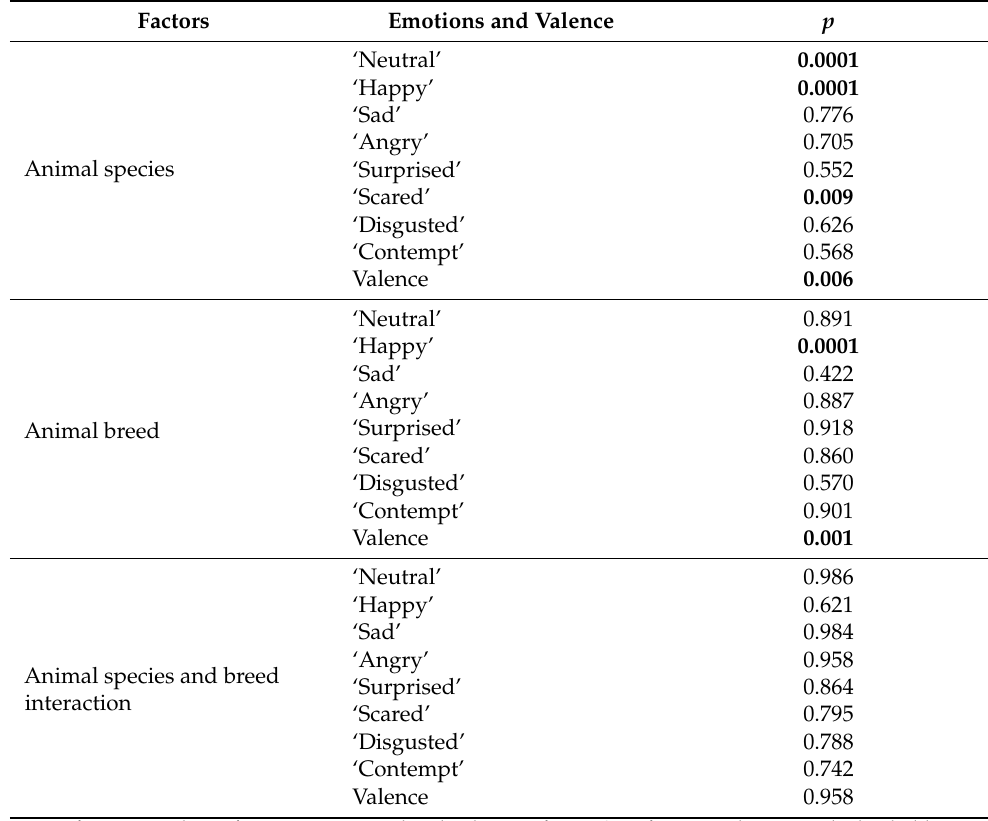
Table 2. Significance of the analyzed factors and their interaction with different animal species and breeds on the emotions induced in